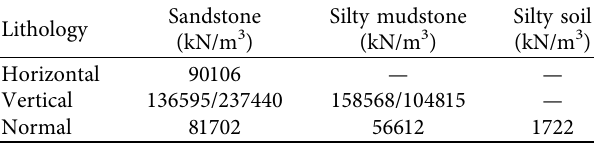
Table 2: Reaction coefficient of every strata.